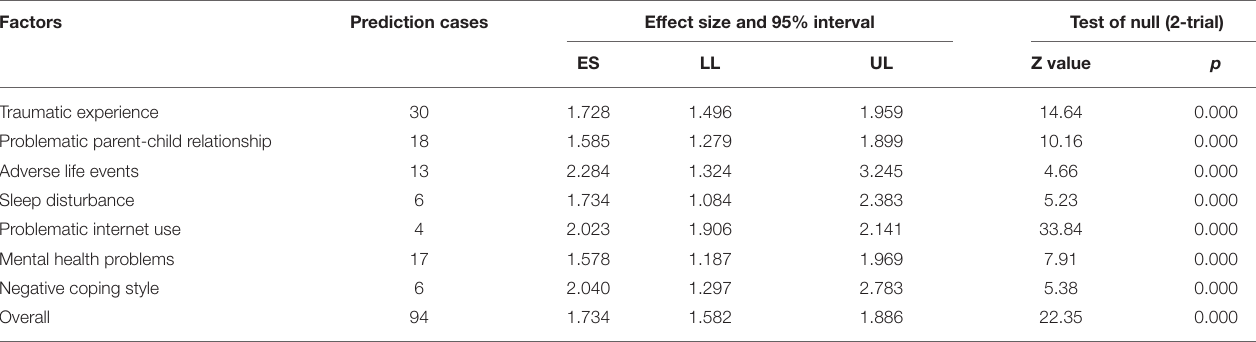
TABLE 2 | Result of all factor analysis of included studies in the meta-analysis.